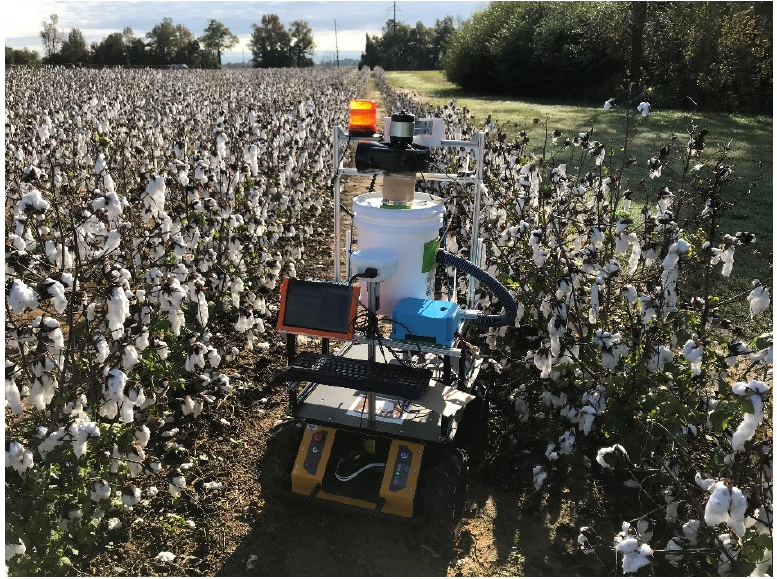
Figure 5. The controller circuit board to control the vacuum motor and blinker; ( a ) base and enclosure, ( b ) Lithium-Ion Polymer (LIPO) battery, and ( c ) low-power indicator.